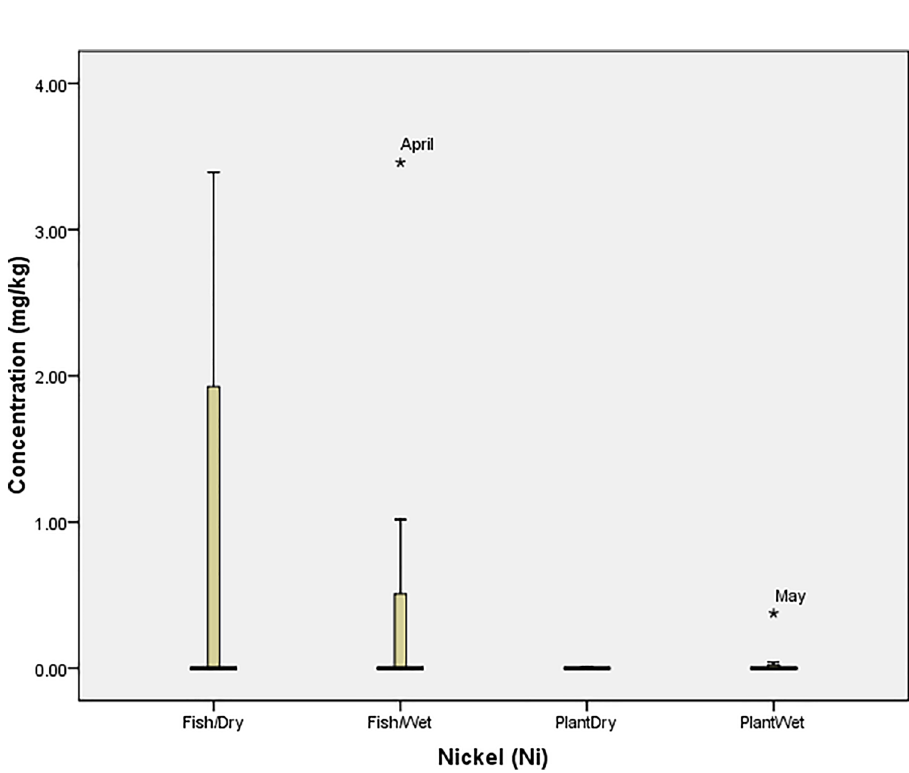
Figure 7. Tolerability of Nickel (Ni) in O. niloticus (Fish) and I. aquatica (Plant) in Wet and Dry Seasons (Source: Field